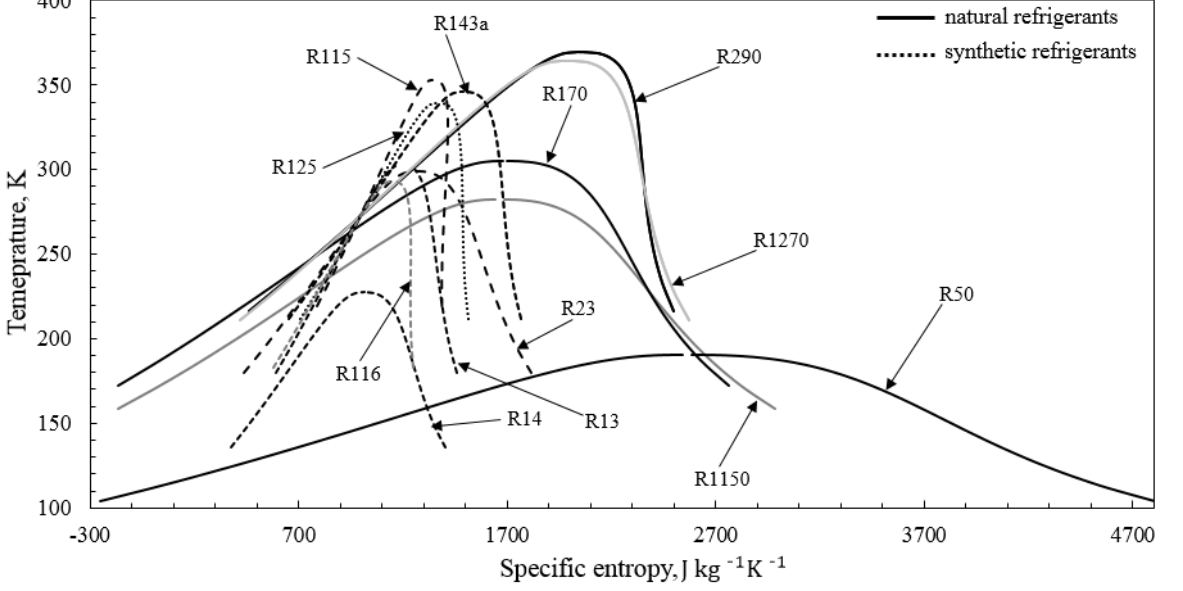
Figure 2. Saturation curves of the refrigerants considered